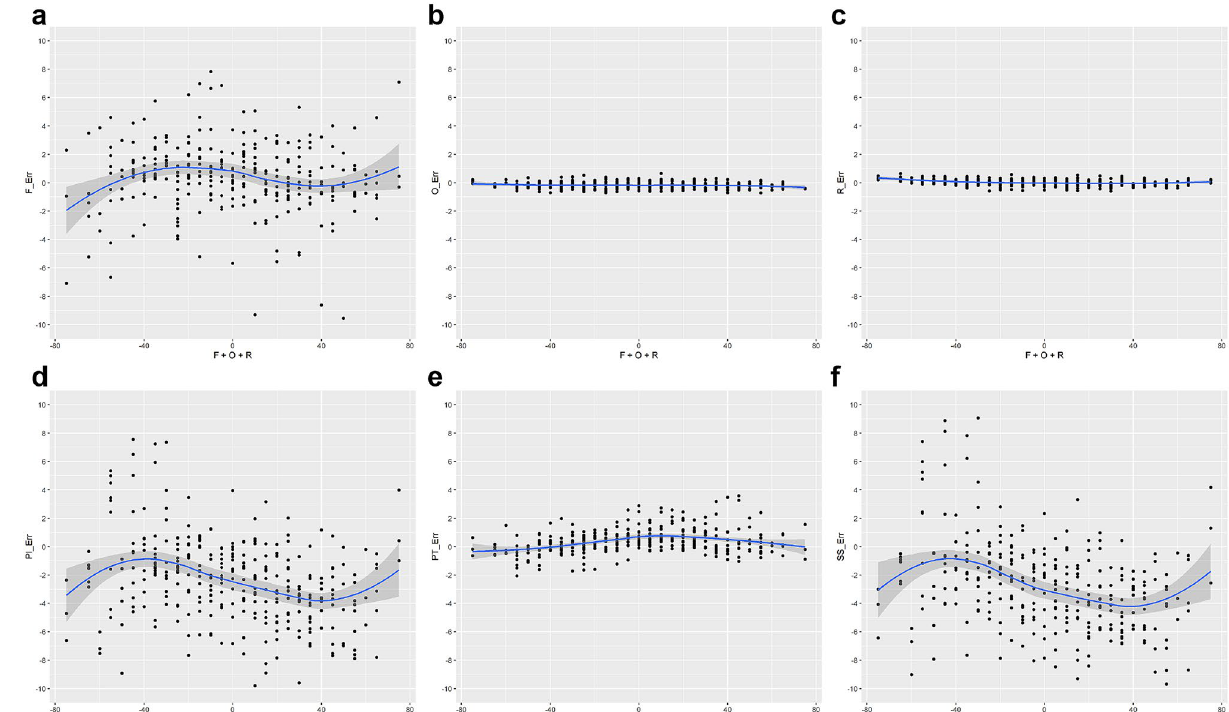
Figure 1. Locally estimated regression graphs for pelvic parameters and orientation. The sum of positional variation values is indicated on the X-axis, and the measurements of each parameter is indicated on the Y-axis. R (version 3.6.1) was used to create the image. ( a ) Flexion, ( b ) Obliquity, ( c ) Rotation, ( d ) Pelvic incidence, ( e ) Spinopelvic tilt, ( f ) Sacral